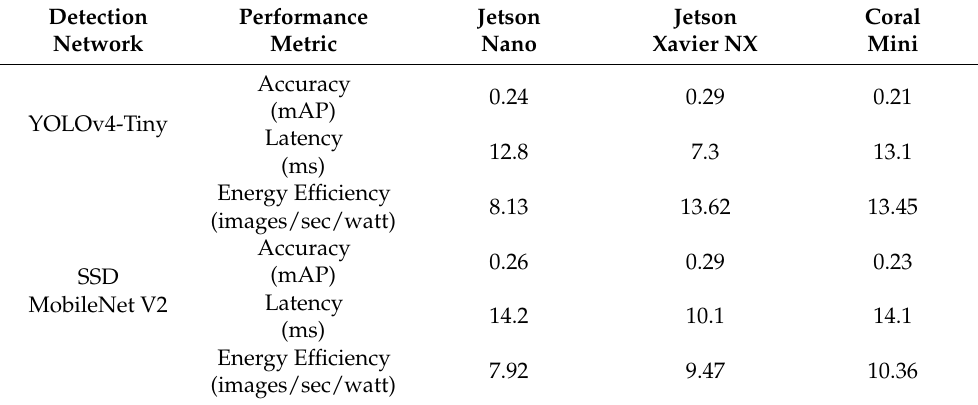
Table 2. Performance Measurement Results of Each Device for Object Detection Networks. Detection